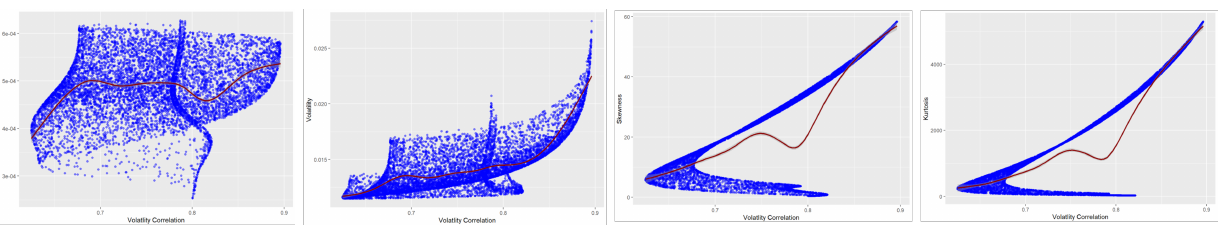
Figure 8. Relationship between mean, volatility, skewness, kurtosis, and volatility correlation of Cryptocurrencies (Group 1).